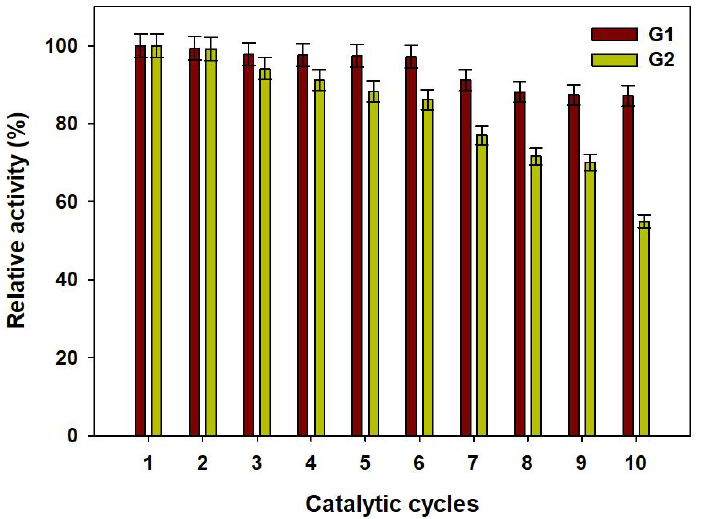
Figure 8. Reusability of lipase immobilized on lignin-based spherical particles. All data are presented as the means ± standard deviation of three experiments.